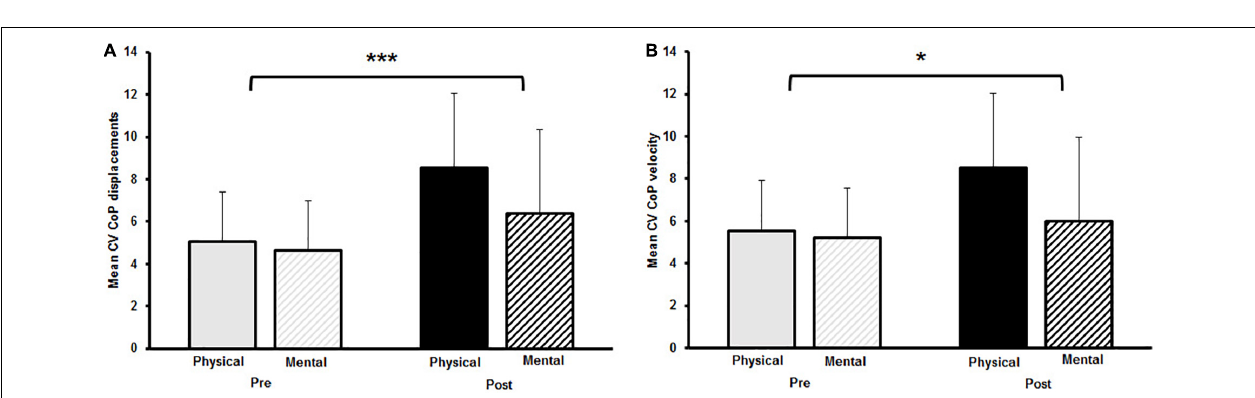
FIGURE 4 | (A) Mean coefficient of variation (CV) for center of pressure (CoP) displacement and (B) mean CV CoP velocity pre and post to physical and mental fatigue. The significant main effect for time is indicated by the bracket with asterisk; * p < 0.05, *** p <